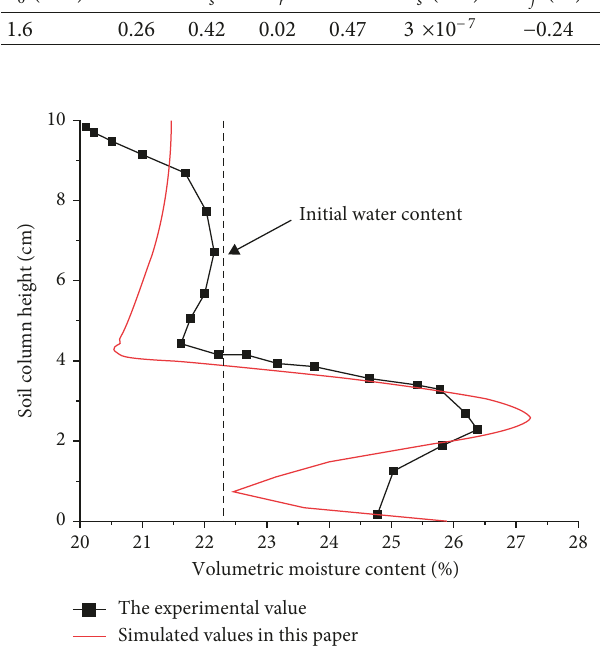
Figure 2: Distribution of volumetric water content in samples.